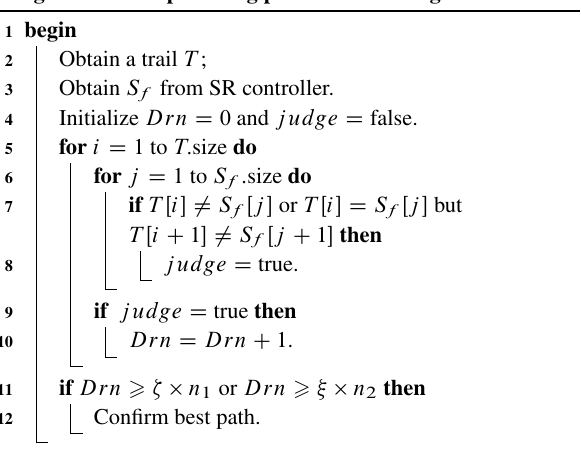
Algorithm 2: (cid:4) Optimizing packet forwarding